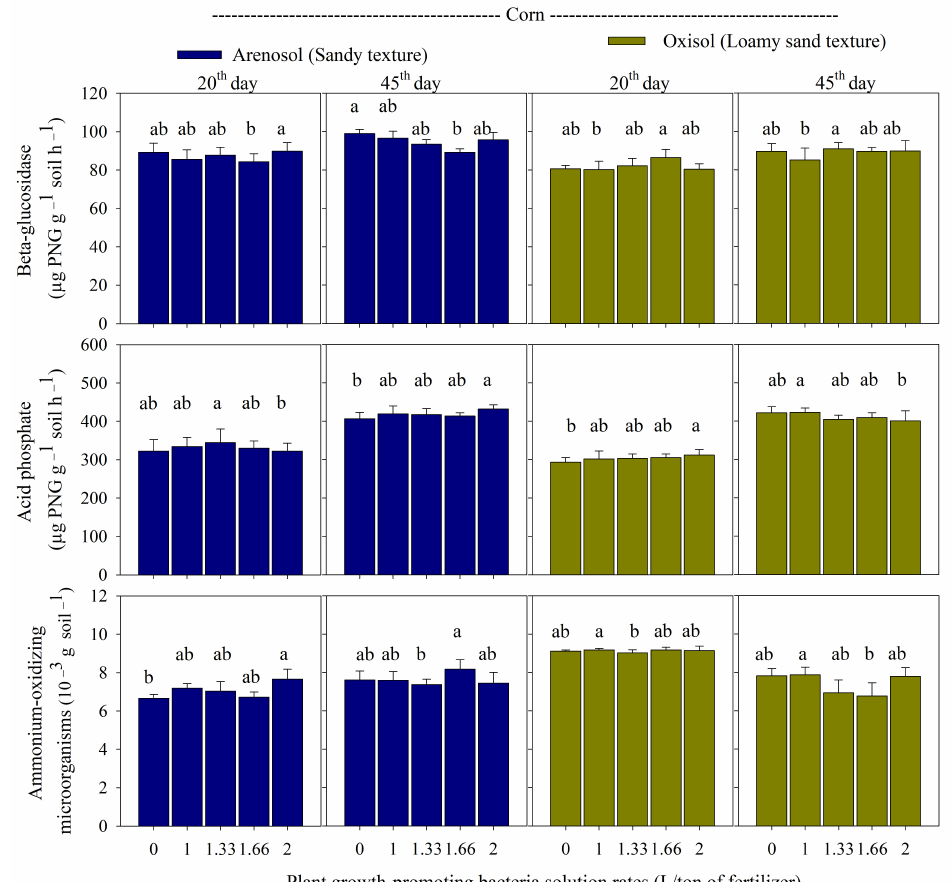
Figure 1. Beta-glucosidase, acid phosphatase, and ammonium-oxidizing microorganisms in an arenosol and oxisol cultivated with corn and application of monoammonium phosphate sprayed with rates of plant growth-promoting bacteria solution (PGPB; 0; 1; 1.33; 1.66; and 2.0 L/ton of fertilizer), in the periods of 20 and 45 days after corn emergence. Deviation bars indicate the standard error from the mean. Lowercase letters represent the comparison between treatments using the Duncan test ( p -value < 0.05). Control is the application of monoammonium phosphate without PGPB. There was a reduction of acid phosphatase on day 20 in arenosoil cultivated with